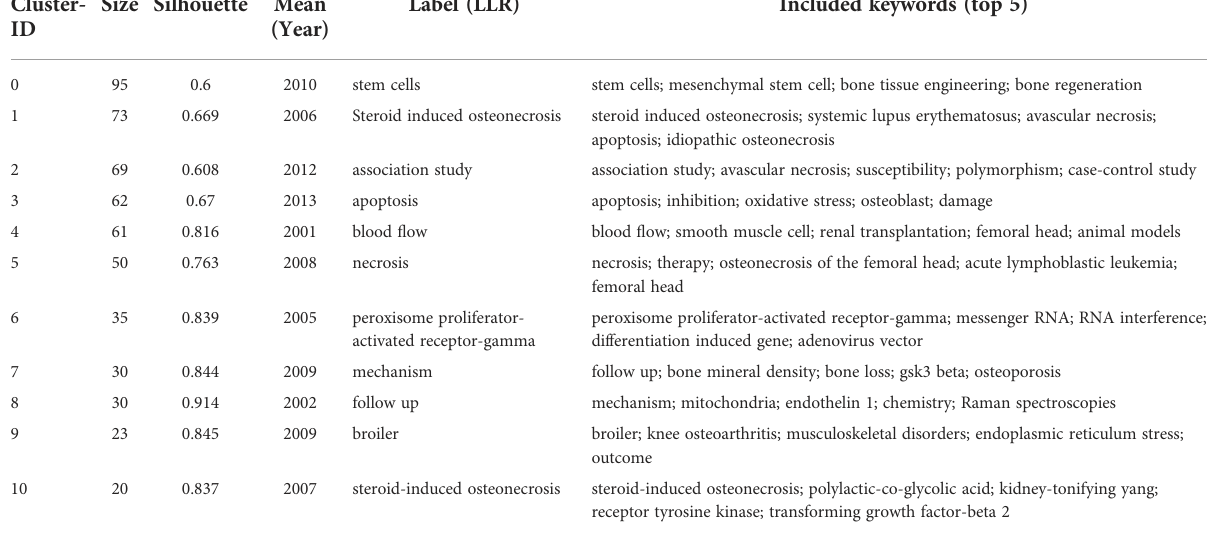
TABLE 3 Summary of the largest 11 keywords clusters. Cluster-